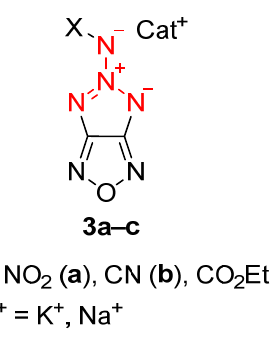
Figure 2. Compounds described in this